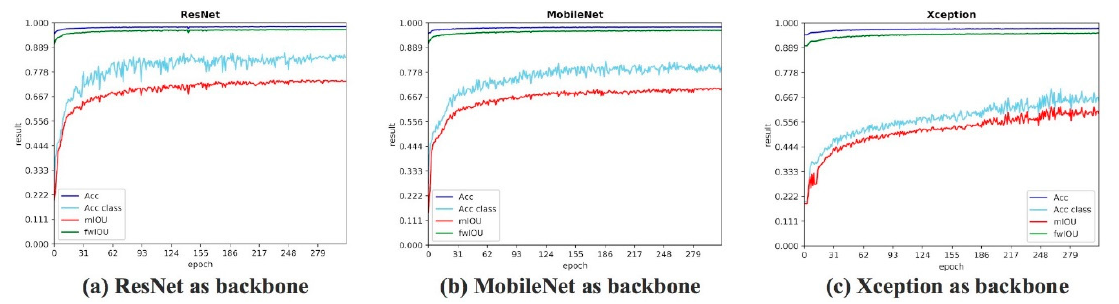
Figure 8. Result of segmentation using different backbone.